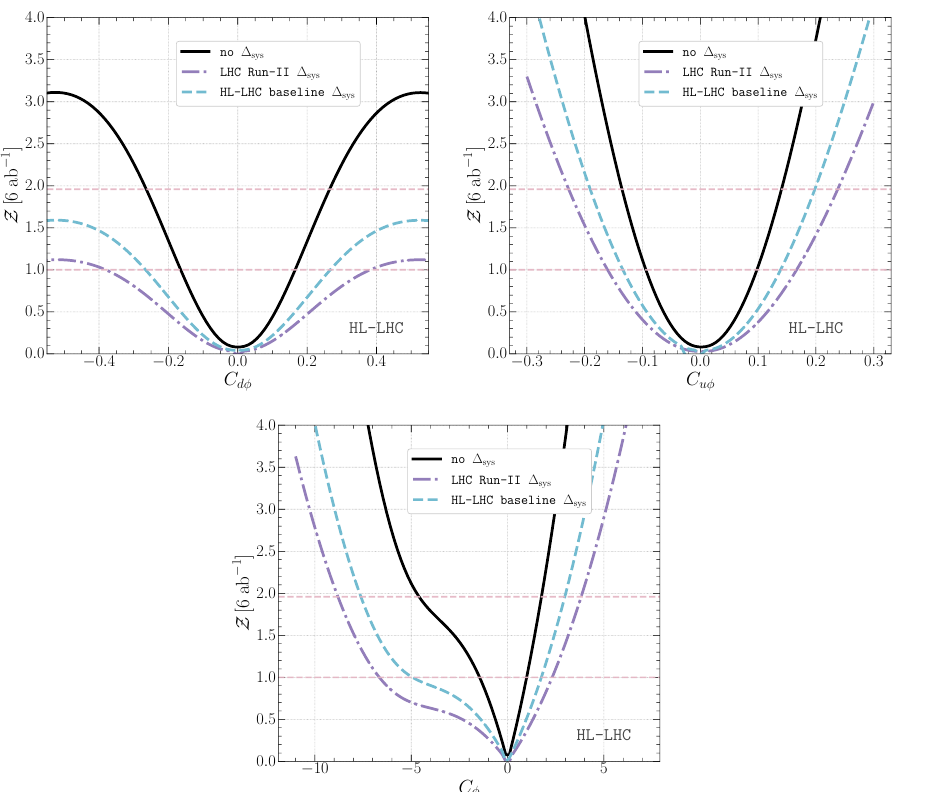
Figure 11 . The significance, Z , from a single parameter fit for C dφ (upper left panel), C uφ (upper right panel) and C (lower center panel) for the HL-LHC with no systematic uncertainties (black) φ and two ansatz for systematic uncertainties. The first is the current Run-II 8.2% in violet and the HL-LHC baseline 5.3% estimated by ATLAS in blue, including theoretical uncertainties without the one stemming from the top mass renormalization